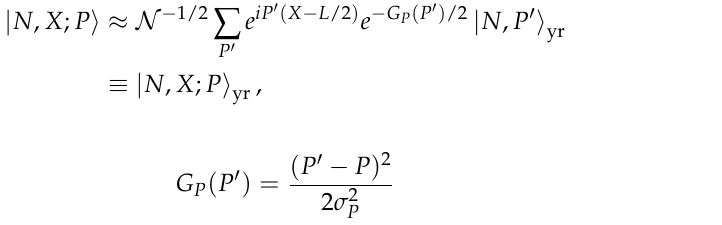
(the Gaussian yr